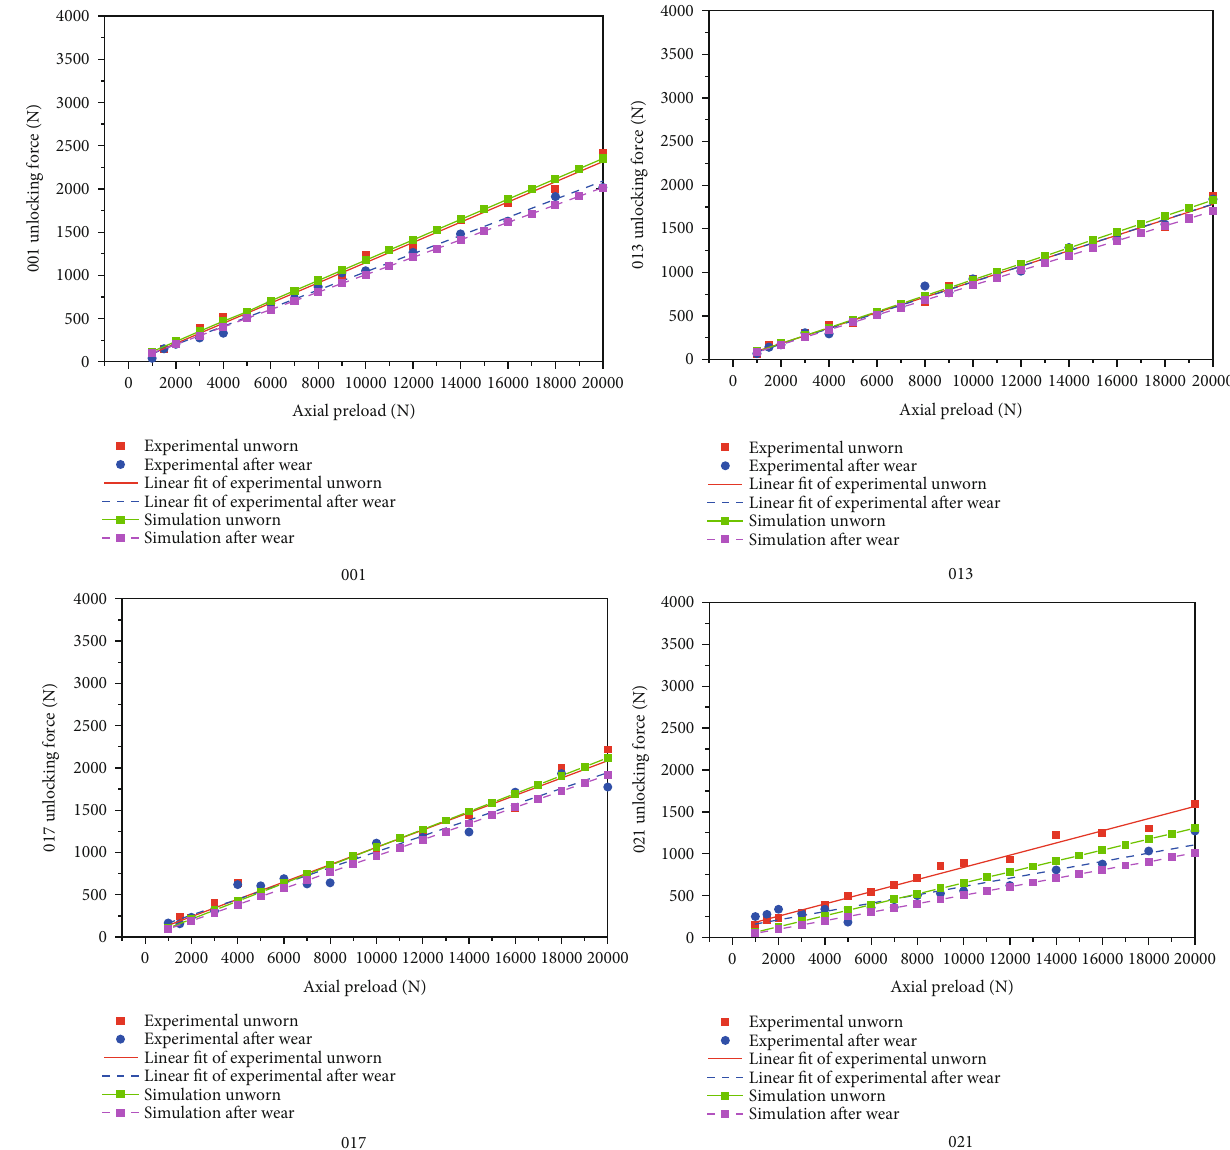
Figure 22: Various types of fi nger lock simulation and experiment comparison curves of unlocking force and axial